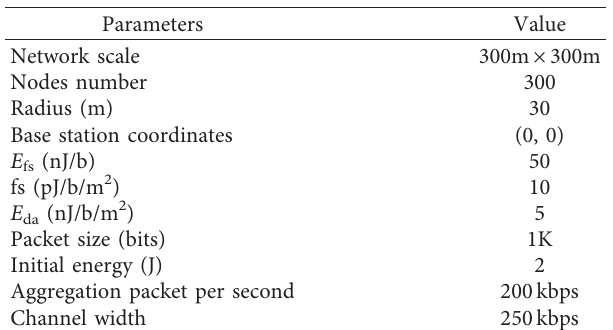
Table 1: Simulation parameters.